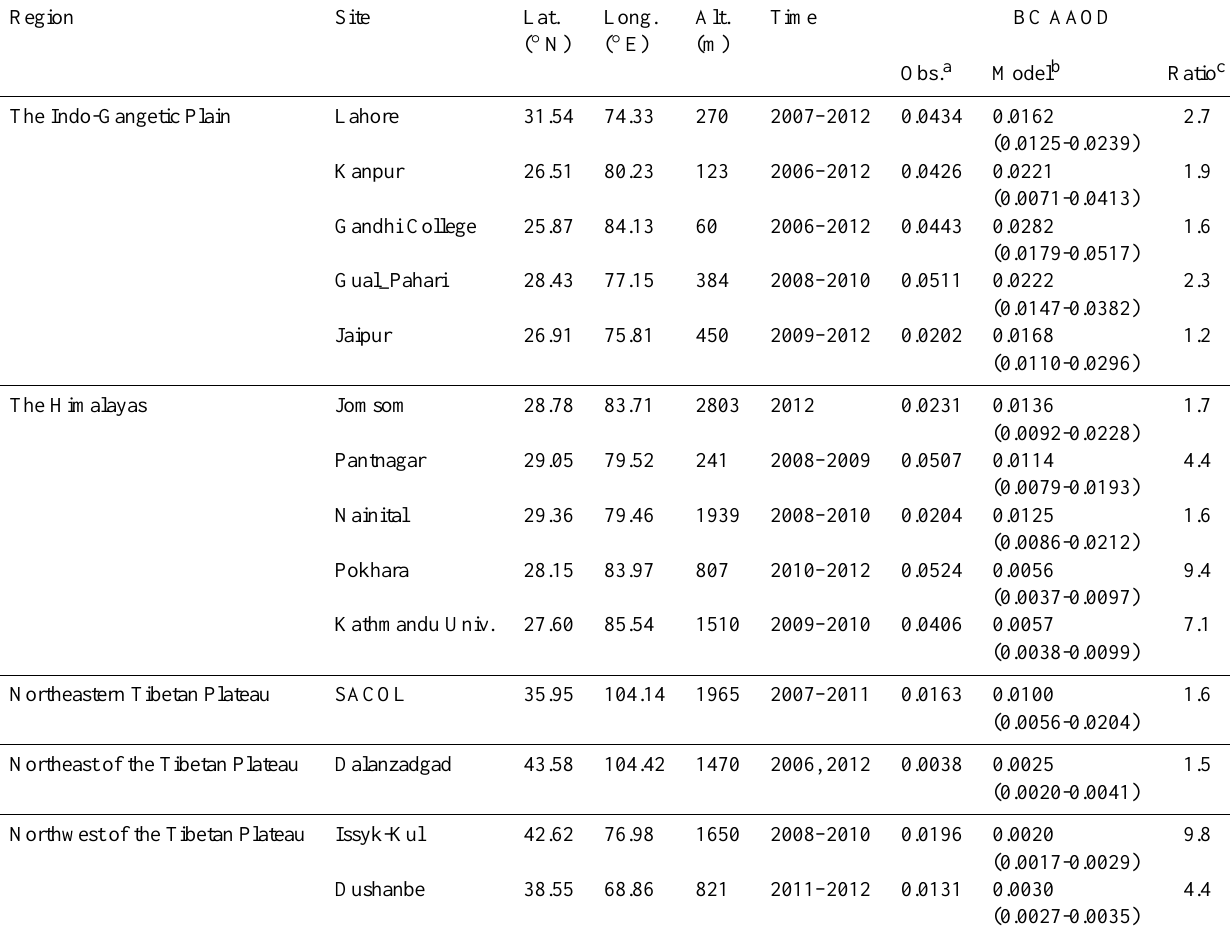
Table 3. Observed and simulated annual mean BC AAOD at AERONET sites over the Tibetan Plateau (see also Fig. 1). Region